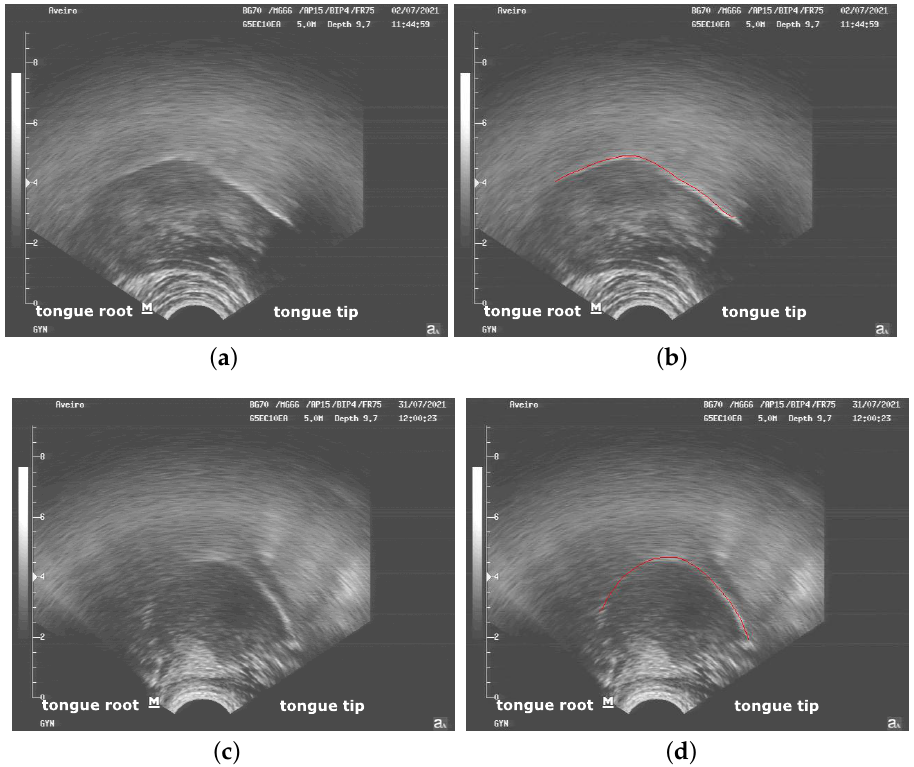
Figure 3. Illustrative US images with the automatic tongue spline of the tongue contour for vowel [a] ( a , b ) and vowel [u] ( c , d ). Left: raw US images; Right: US images with automatic tongue